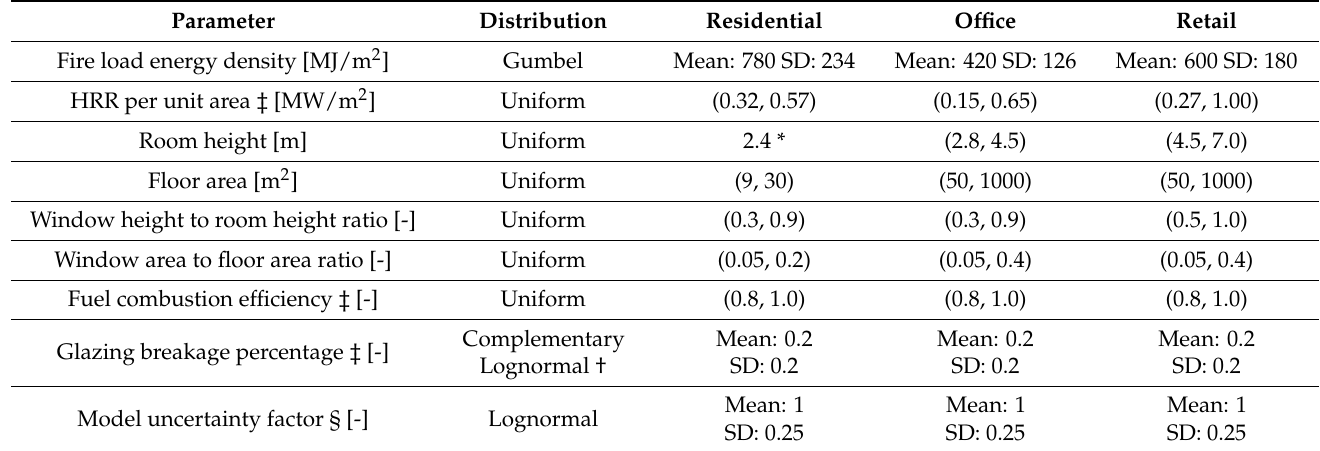
Table 8. Key parameters adopted for the time equivalence MCS.